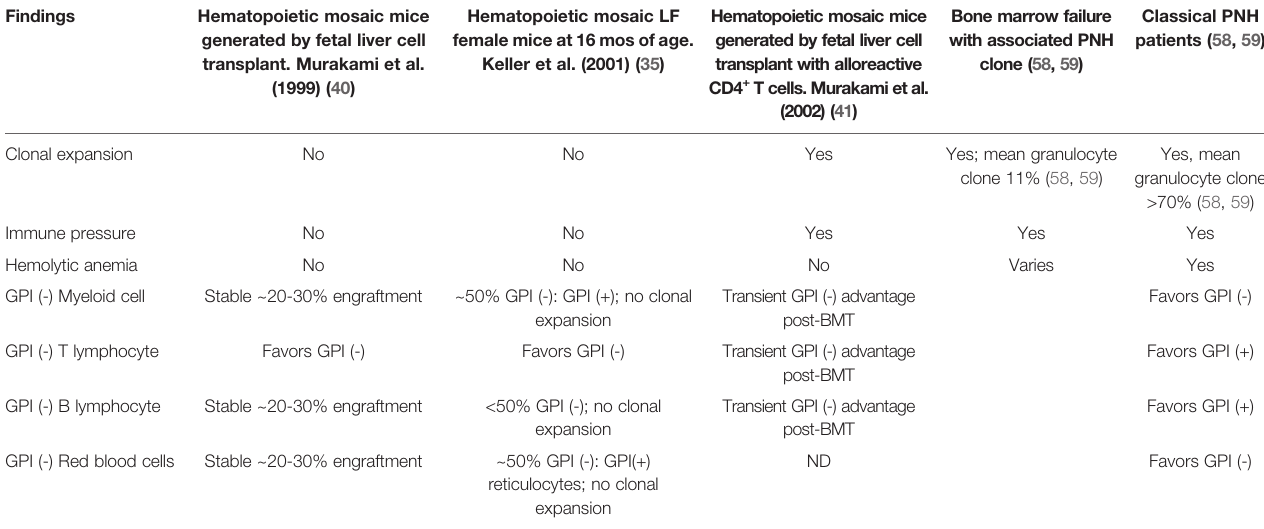
TABLE 2 | Comparison of hematologic fi ndings in PNH patients and mouse models of PNH.